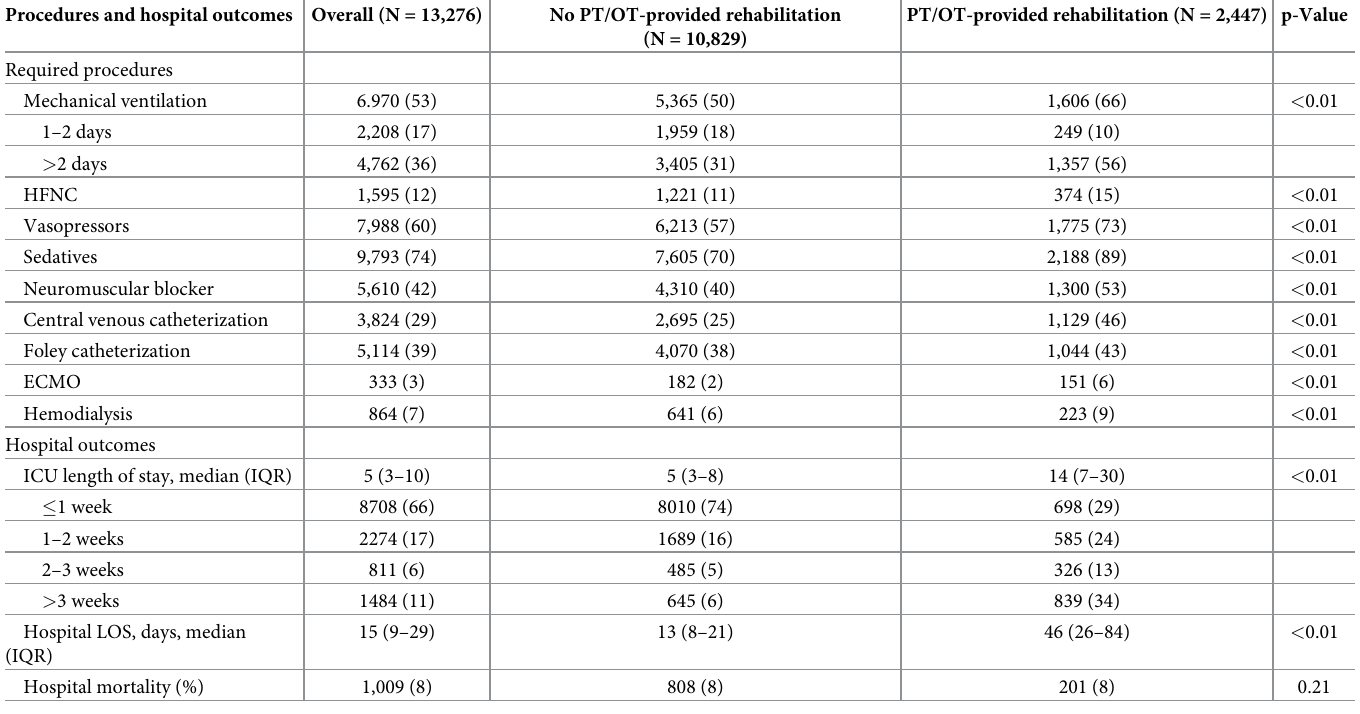
Table 2. Required procedures and hospital outcomes of ICU patients according to PT/OT-provided rehabilitation in Korea, January 2013 to July 2019. Procedures and hospital outcomes Overall (N =